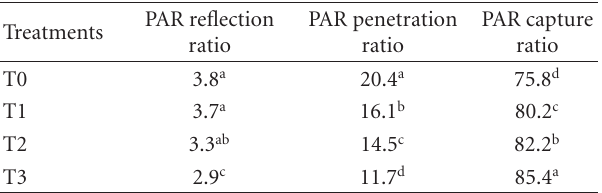
Table 2: E ff ect of irrigation during the winter wheat growing season on the PAR reflection ratio, PAR penetration ratio, and PAR capture ratio in summer maize canopy (%).